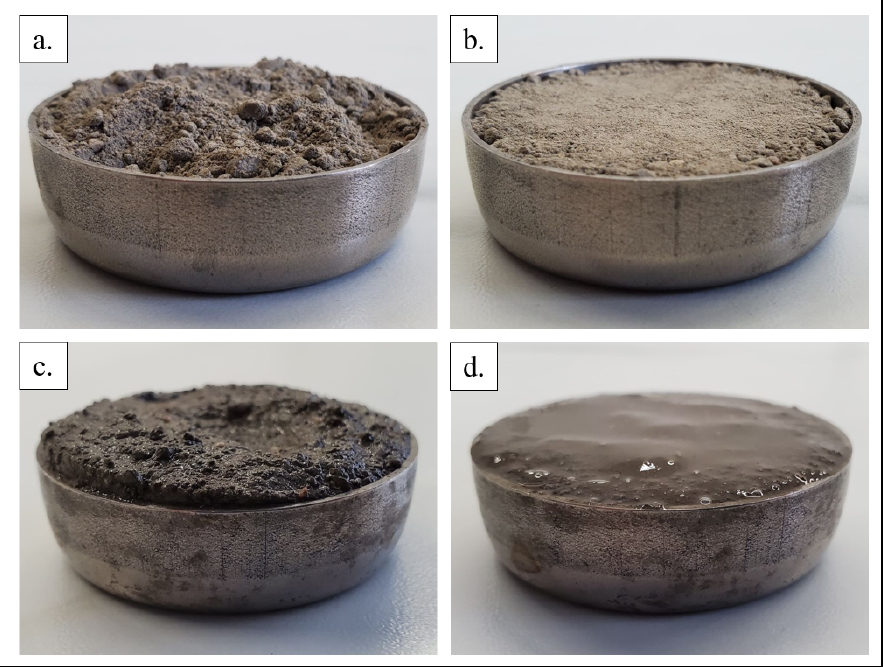
Figure 3. Stages of soil preparation: ( a ) oven dried and unconsolidated soil, ( b ) dry soil tamped down and levelled with cup, ( c ) swelling 12 hours after saturation, and ( d ) wet soil tamped down.